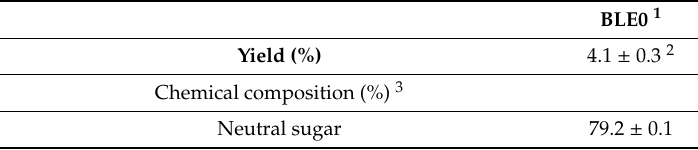
Table 2. Chemical properties of polysaccharides manufactured from pectinase-treated H. vulgare leaves